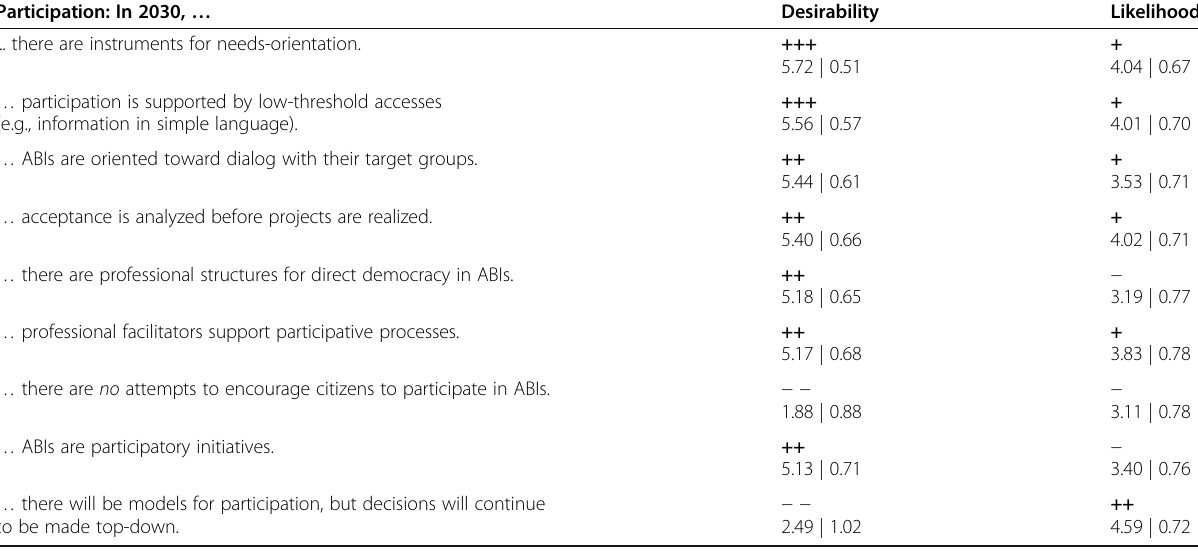
Table 7 Means and standard deviations for statements about participation with civil society Participation: In 2030, … Desirability